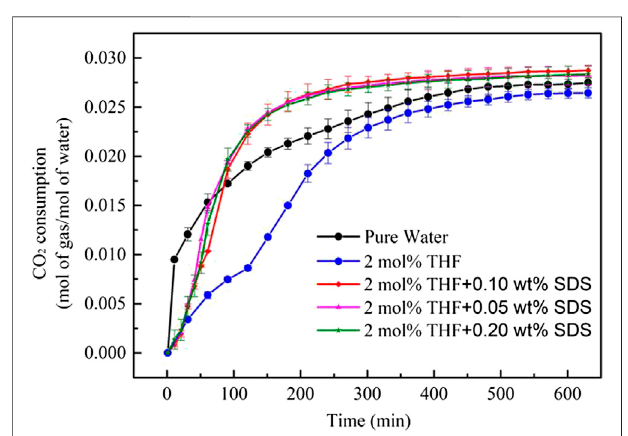
FIGURE 7 | CO 2 consumption curves (normalized by water amount) during CO 2 hydrate formation with different initial molar concentrations of